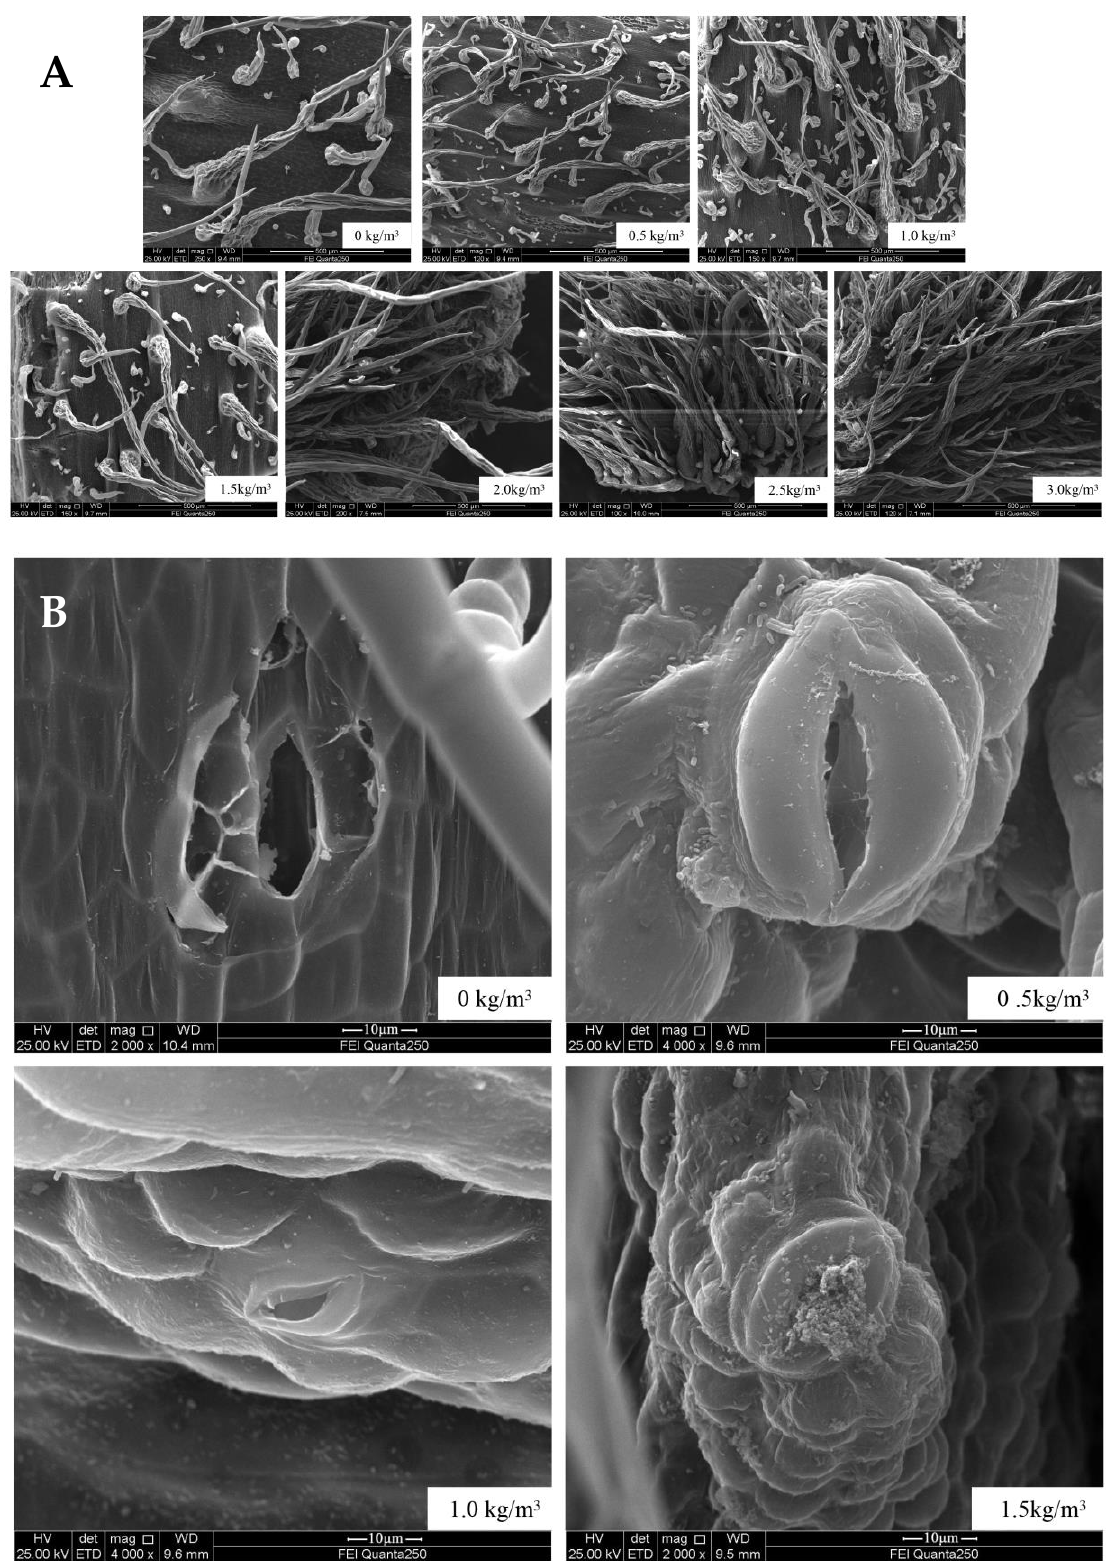
Figure 2. The distribution characteristics of trichomes in kiwifruit stems when sulfur contents are 0 to 3.0 kg/m 3 ( A ), and the morphology of lenticels in kiwifruit stems when sulfur content is 0.5 to 1.5 kg/m 3 ( B